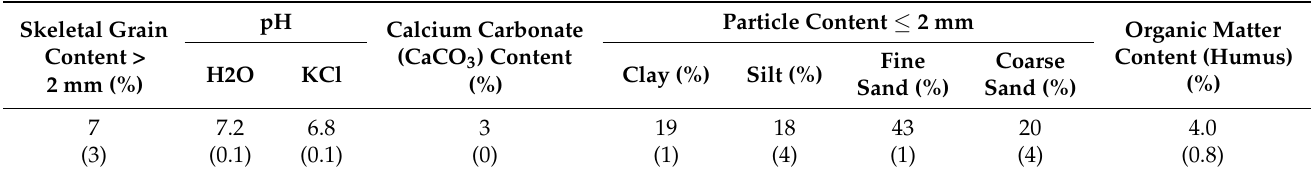
Table 2. Soil characteristics of testing field. Average values of 5 samples are presented with variation in